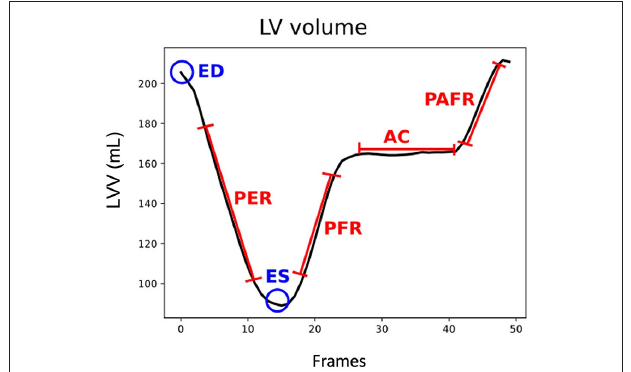
FIGURE 2 | LV volume (LVV) curve for a cardiac cycle, in blue end diastole (ED) and end systole (ES) frames, in red peak ejection rate (PER), peak filling rate (PFR), atrial contribution (AC), and peak atrial filling rate (PAFR)